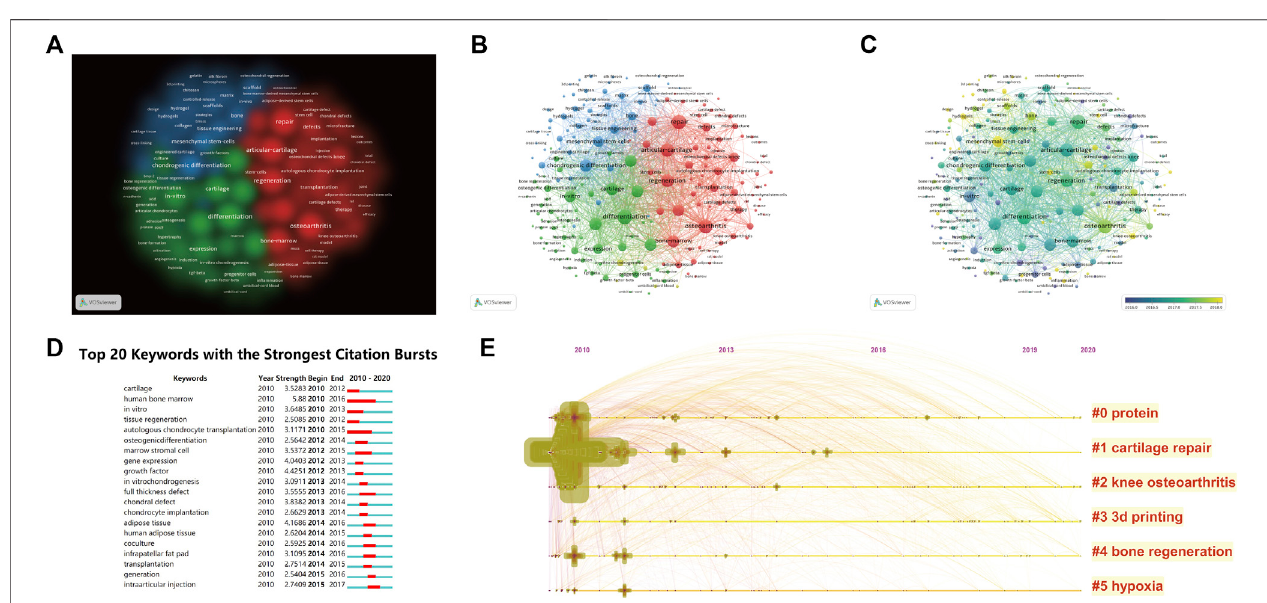
FIGURE 6 | Mapping of keywords in studies on stem cells for cartilage regeneration. (A) Clustering analysis of key words based on VOSviewer. (B) Network visualizationofkeywordsbasedonVOSviewer. (C) ChronologicalorderofkeywordsbasedonVOSviewer. (D) Top20keywordswiththestrongestcitationburstsbased on CiteSpace. (E) Keyword timeline visualization from 2010 to